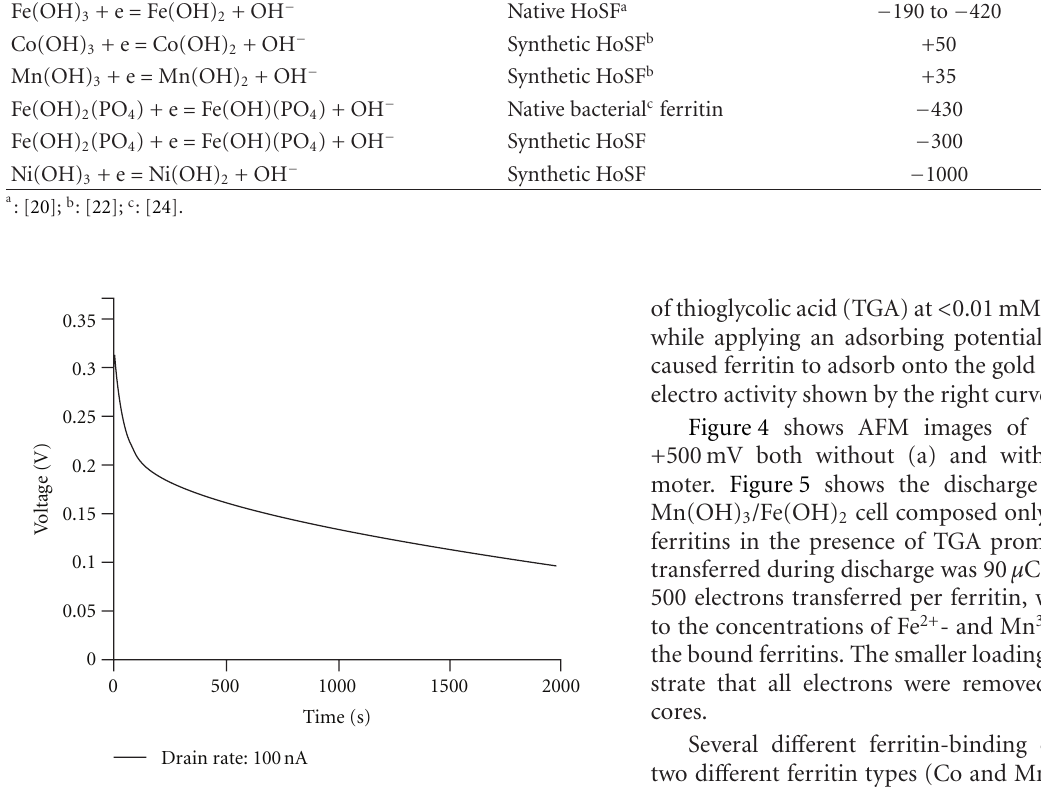
Figure 2: Voltage versus time discharge curve. A small, unstirred bulk electrochemical cell consisting of ferritin containing a Fe(OH) 2 mineral core connected to a ferritin containing Co(OH) 3 mineral core in 0.05 M MOPS pH 8.0 was discharged at a drain rate of 100nA. Each ferritin contained ∼ 2000 metal ions per mineral